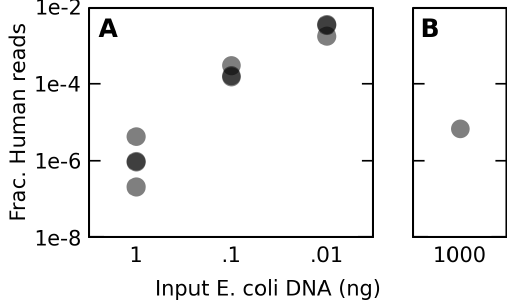
Figure 1. Reads matching the human genome are more prevalent in libraries prepared from dilute samples. (a) The fraction of paired-end reads which preferentially map to the contaminant human genome instead of the E. coli K-12 genome, measured against the total number of reads in the library, is plotted against the amount of E. coli K-12 DNA used per tagmentation procedure as described by Parkinson et al [18]. Shading is used to highlight closely overlapping points (n=4, 3, and 3 for the 1ng, 100pg, and 10pg libraries, respectively). Libraries listed at each concentration were not identically prepared, each using a different restriction enzyme or set of restriction enzymes at an intermediate step in the protocol (Additional File 1, Table S1), but the number and composition of enzymes used did not appreciably change the number of contaminant reads recovered. (b) The same fraction is plotted for a library prepared in the same experiment using a standard Illumina library preparation protocol. Despite a higher concentration of input DNA, an intermediate number of contaminant reads was detected. Illumina protocol, despite its higher concentration of sample DNA (Figure 1B).